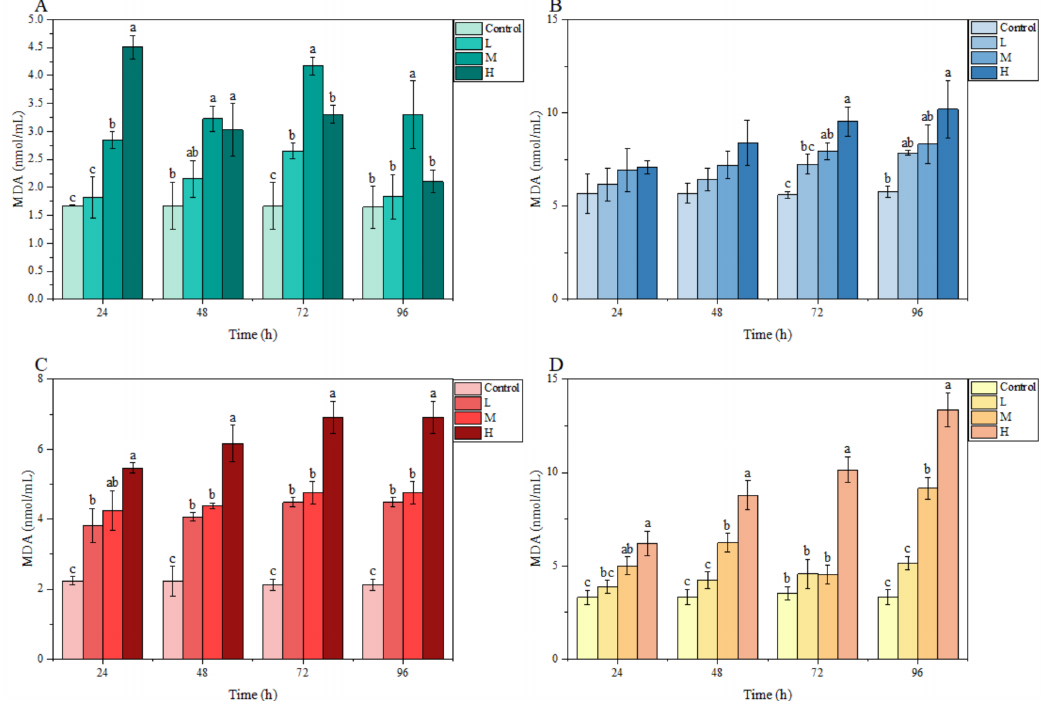
Figure 4. Effects of ammonia stress on MDA content of juvenile M. salmoides. ( A – D ) represent the MDA content in the gill, brain, liver, and kidney, respectively. The bars represent the mean ± S.D. ( n = 3). Different letters indicate statistical differences ( p <